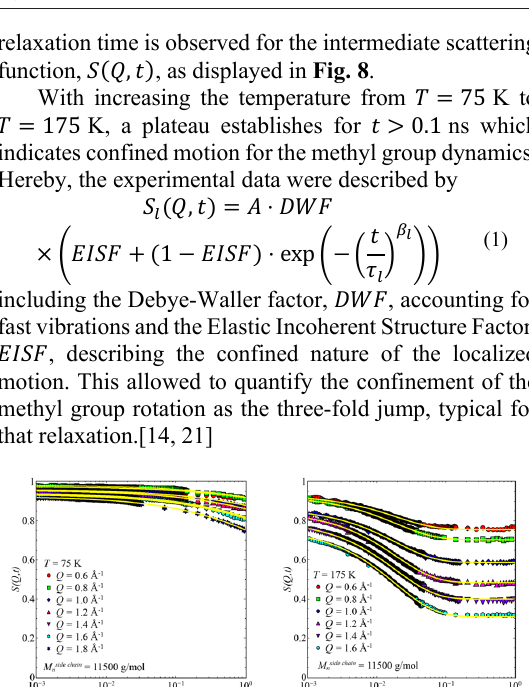
(b) Fig. 8. Intermediate scattering function, 𝑆(cid:4666)𝑄 , 𝑡(cid:4667) , as a function of time, 𝑡 , for Sample 3 for two selected temperatures, (a) 𝑇 (cid:3404) 75 K, and (b) 𝑇 (cid:3404) 175 K. Solid lines are the best description with the model function, equation (1). Data has been previously published at Bichler et al .[14]